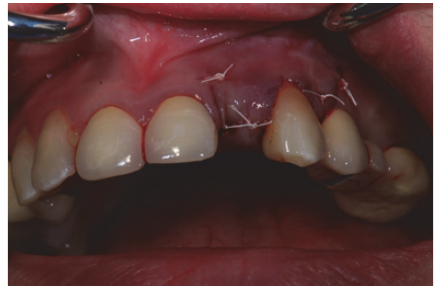
Figure 5: Following implant placement and suturing.